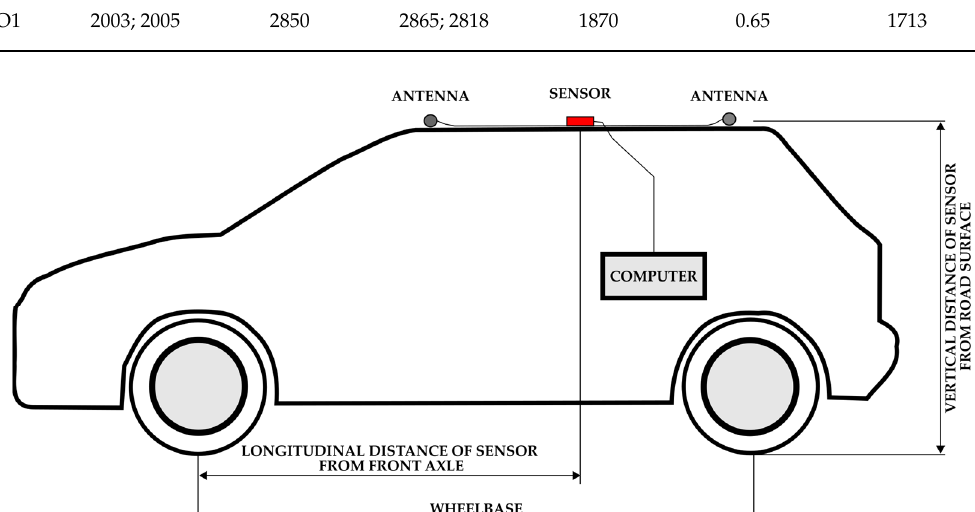
Figure 5. Van vehicle V7 ( left photo ) and vehicle combination V10 ( right photo ) used in tests.